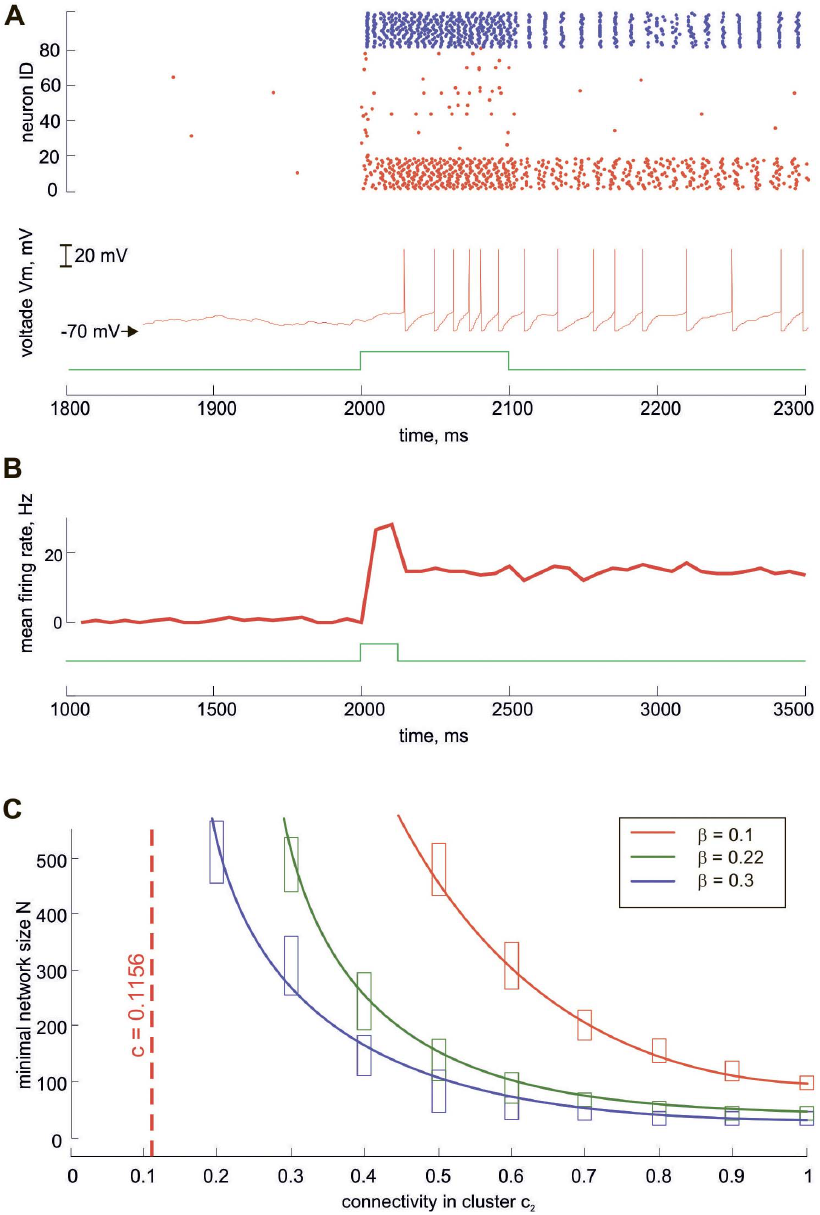
Figure 4. Bistability of the NC dynamics. A , The network switching from the ‘‘low’’ to the ‘‘high’’ state by a transient external simulation. Top: spike raster of the network, red dots for excitatory and blue dots for inhibitory neurons. The clustered neurons have identities from 1 to K =18. Bottom: output voltage of one of the clustered neurons (red) and the external signal (green). B. Stability of the low and the high states. The network is simulated by a transient pulse lasting 100 ms (green curve). The mean firing rate of the network (red curve) is around zero before the stimulation, then increases and remains elevated ( , 20 Hz) even when the stimulation is terminated. Note that A and B use different scales of the time axes. C. The minimal network size N sufficient for the bistability emergence depending on the connectivity inside the cluster c 2 . The curves of different colors correspond to various values of b =0.1 (red), b =0.22 (green), b =0.3 (blue). doi:10.1371/journal.pone.0094292.g004 were not changed. As a result, we obtained a network with local clusters of densely connected neurons, sparse connectivity on the global scale and log-normal distribution of EPSPs. The network received no external background input.